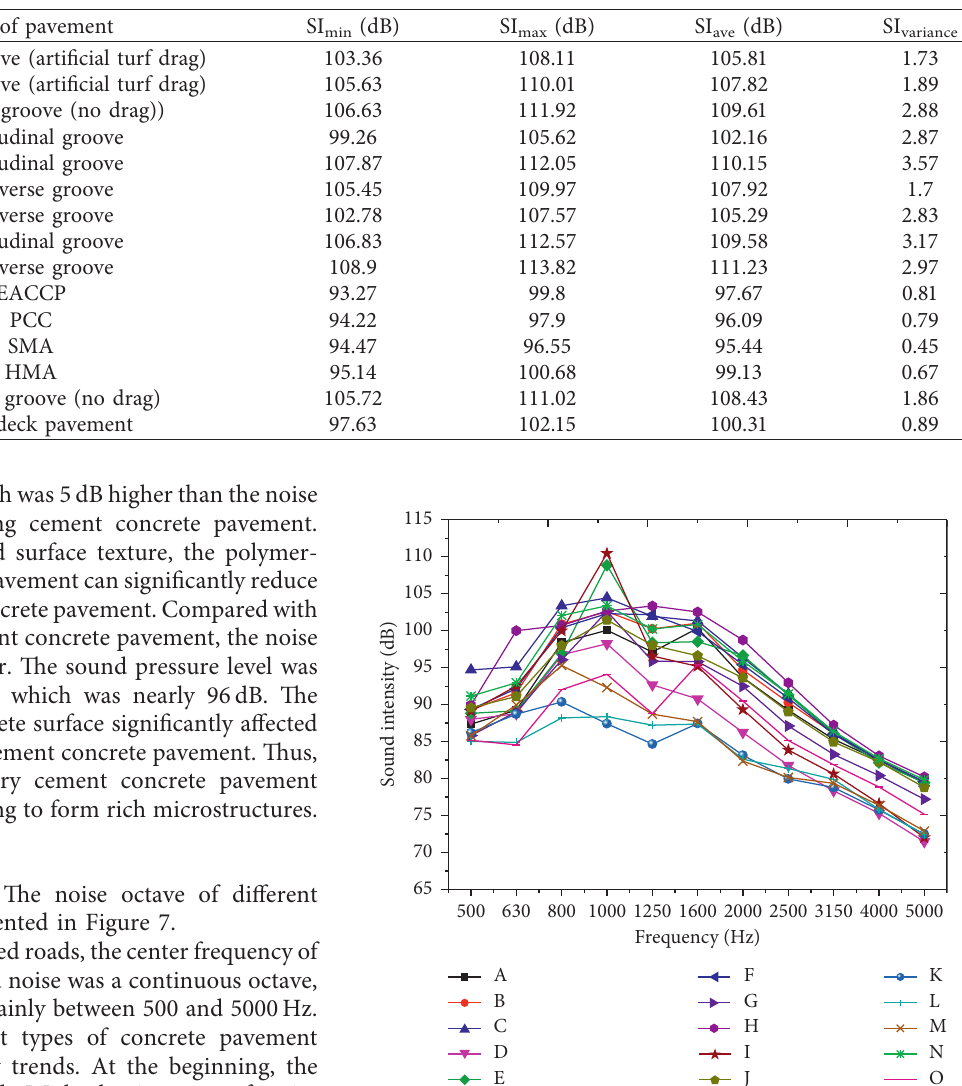
Table 4: Noise of pavement test results.